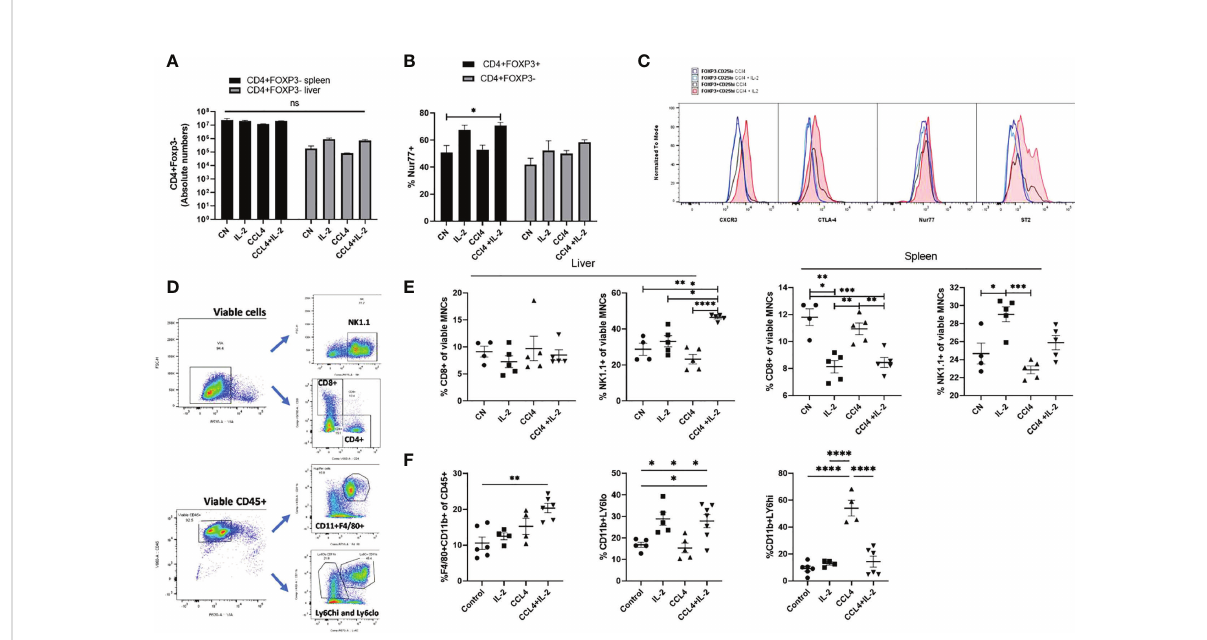
FIGURE 5 Characterisation of intra-hepatic cell subsets impacted by IL-2 administration and CCL ₄ induced in fl ammation. (A) Absolute numbers of CD4 +Foxp3- cells were quanti fi ed in liver and spleen in homeostasis, following IL-2c administration, CCL ₄ induced in fl ammation and IL-2c administration prior to CCL ₄ induced in fl ammation (n=5). (B) Percentage expression of NUR77 was compared between CD4+CD25+FOXP3+ Tregs and CD4+CD25+Foxp3- Effector T cells (n=4). (C) Additionally, these cell subsets were compared for changes in activation characterised by CTLA-4 and NUR77 expression and liver-speci fi c regulation and homing seen by differences in ST2 and CXCR3 expression following CCL ₄ alone or with IL-2 treatment, the plot is representative of 4 individual experiments (D) Gating strategy employed to characterise cell subsets. (E) Effect of CCL ₄ induced liver injury with or without exogenous IL-2c on the percentage of CD8+ Effector T and NK cells in liver and spleen were summarised (n=4). (F) Changes in the hepatic non-parenchymal cell subsets were quanti fi ed by looking at the percentage abundance